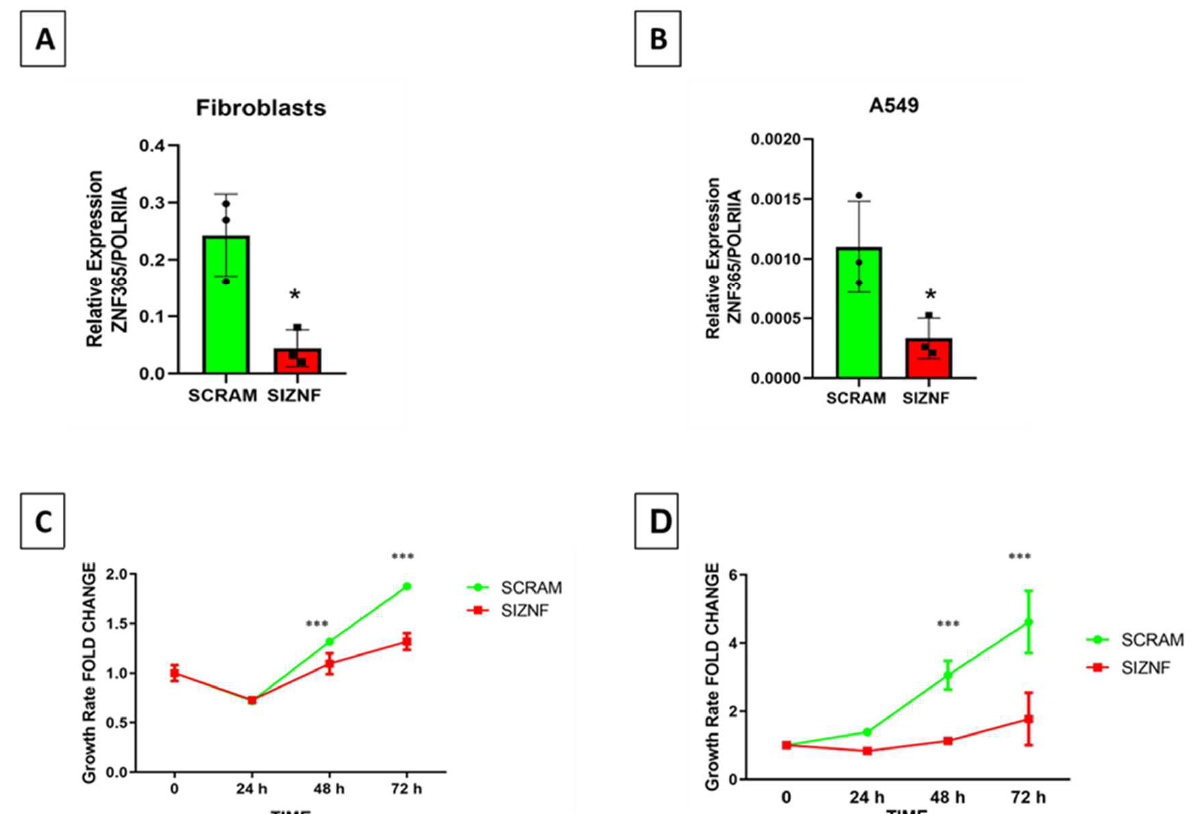
Figure 5. Silencing of ZNF365 reduces fibroblasts and A549 cells growth rate. ( A ) Expression of ZNF365 was examined by qPCR in normal human lung fibroblasts silenced. ( B ) Expression of ZNF365 by qPCR analysis in silenced A549 cells. “SCRAM” corresponds to the scrambled control sequences and “SIZNF” to specific siRNA sequences for ZNF365. ( C ) Growth rate assay of normal human lung fibroblasts using WST-1 reagent. ( D ) Growth rate assay of A549 cells using WST-1 reagent. Graphics represent three independent experiments by triplicate (qPCR) and curves represent one of three independent experiments by quadruplicate (WST-1) (mean ± standard deviation). * p < 0.05, by a two-tailed Student’s t -test with Welch’s correction; *** p < 0.001 by two-way ANOVA with Bonferroni’s posttest.